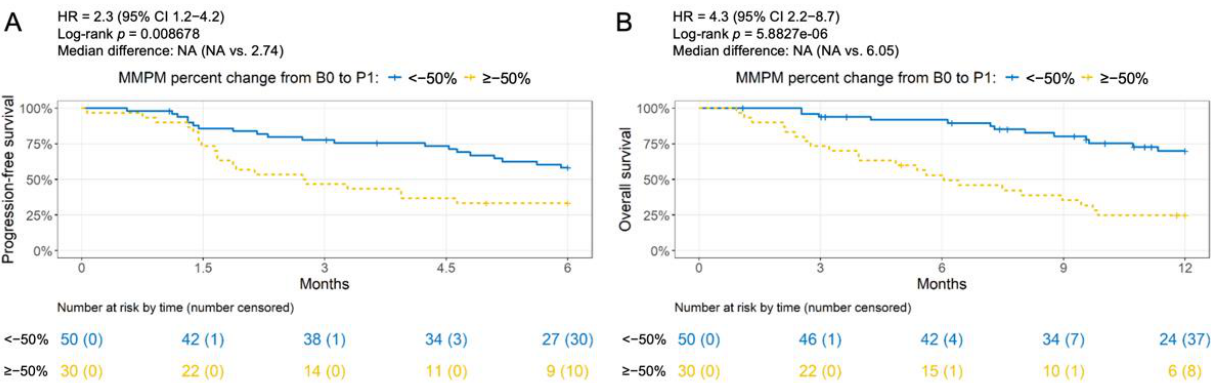
Figure 3. Association between survival and ctDNA decrease after one chemotherapy cycle. Progression-free survival ( A ) and overall survival ( B ) for >50% vs. ≤ 50% decrease in mean mutant molecules per milliliter (MMPM) from baseline in the first available plasma after one cycle of chemotherapy.